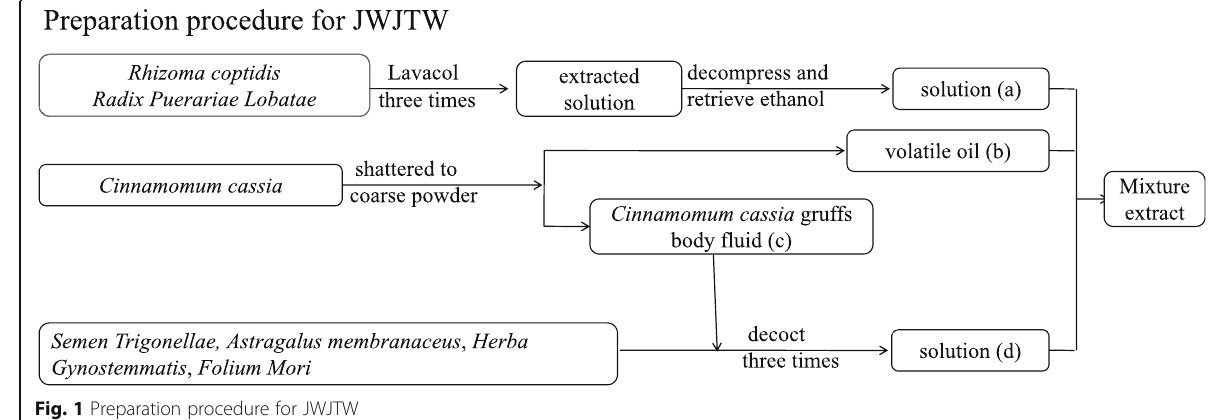
Fig. 1 Preparation procedure for JWJTW